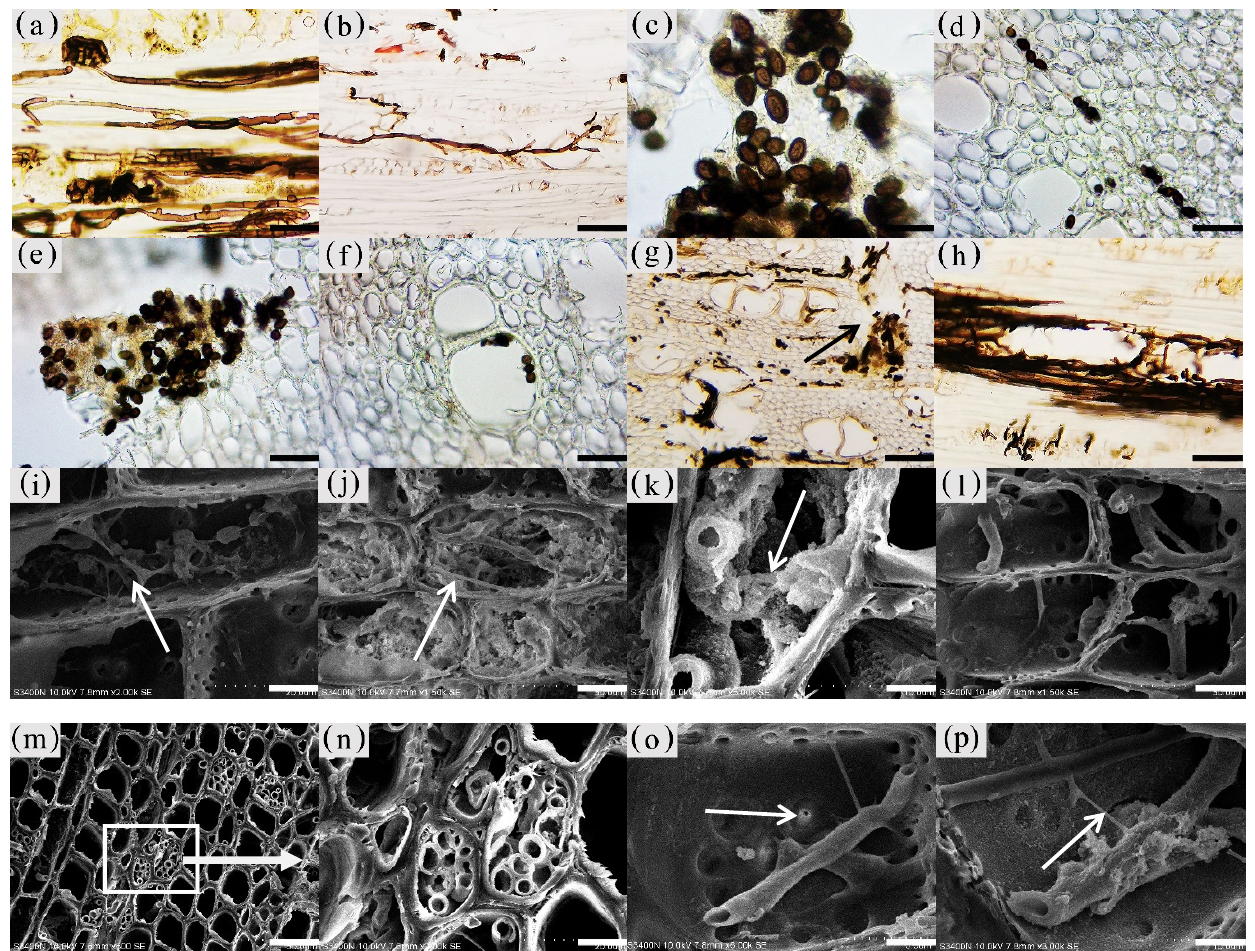
Figure 13. Distribution of fungal propagule and hypha in parenchyma cells and vessel. ( a ) Mycelial morphology of the xylem. ( b )Type of mycelial dispersal. ( c ) Fungal propagule morphology. ( d ) Fungal propagules in xylem rays of decay zone. ( e ) Fungal propagules in the interxylary phloem of decay zone. ( f ) Fungal propagules in the vessel of decay zone. ( g ) Transverse surface of decay zone, mycelium distributed in xylem rays and axial parenchyma, with the decayed interxylary phloem at the arrow. ( h ) Fungal hypha in vessel of radial surface which in decay zone. ( i ) Fungal hypha in xylem rays of radial surface which in transition zone, with mycelium at arrows. ( j , k ) Transverse surface of agarwood zone, inclusions and mycelium in xylem rays, with mycelium at arrows. ( l ) Fungal hypha in xylem rays of radial surface which in decay zone. ( m , n ) Fungal hypha in fiber of transverse surface which in decay zone, Figure n is a partial enlargement of Figure m. ( o ) Branching hyphae infect adjacent cells through the pit. ( p ) Xylem rays of radial surface which in decay zone-the arrow shows the mycelium fusion between the branching mycelium and the main mycelium. Scale bars= ( a , d – f ), ( h ) 50 µm; ( b ) 100 µm; ( c , i , n ) 10 µm; ( g ) 200 µm; ( j , l ) 15 µm; ( k ) 4 µm; ( m ) 35 µm; ( o ) 3.5 µm; ( p ) 7 µm.